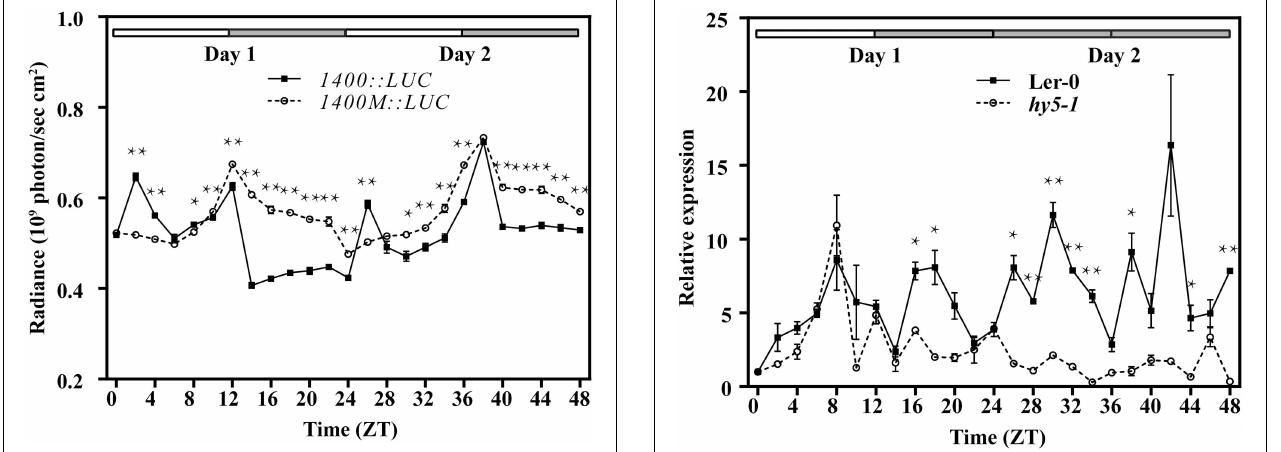
FIGURE 5 | Rhythmic expression of the luciferase gene ( LUC ) driven by the 1400 bp upstream fragment of the QH6 promoter in transgenic Arabidopsis thaliana Ler-0 and hy5-1 mutant lines. The steady-state level of LUC transcripts was quantified by real-time PCR, using Actin8 as a reference gene. Leaves were sampled in triplicate for two continuous days, with the first day in standard 12h/12h light/dark cycle and the second day in constant dark. ZT is Zeitgeber time and here represents time from light on at dawn. Filled and open bars indicate subjective days and nights. Data represent means ± SD. The differences of expression levels were assessed by unpaired Student’s t -test. * p < 0 . 05 and ** p < 0 . 01 in 1400::LUC transgenic Ler-0 vs. 1400::LUC transgenic hy5-1